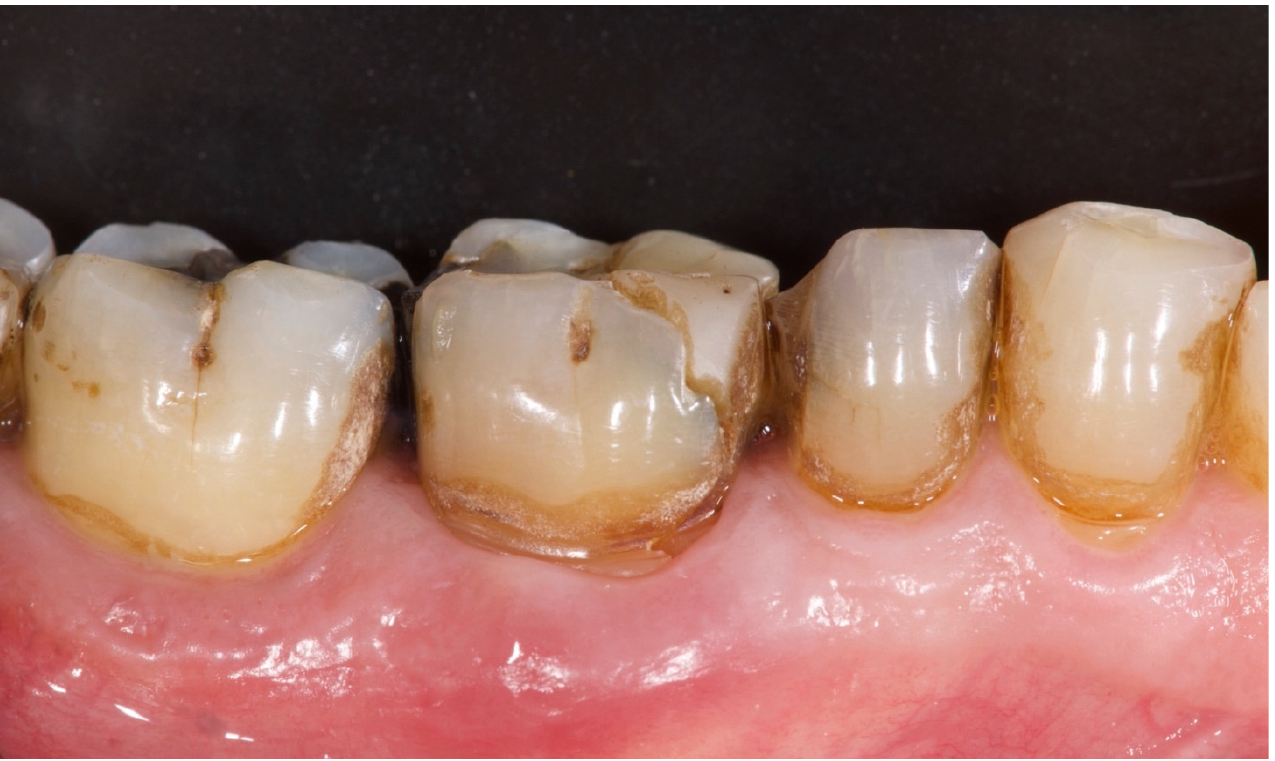
Figure 1. Preclinical situation of patient number 3. Lower right first molar needed to be extracted due to a vertical fracture.